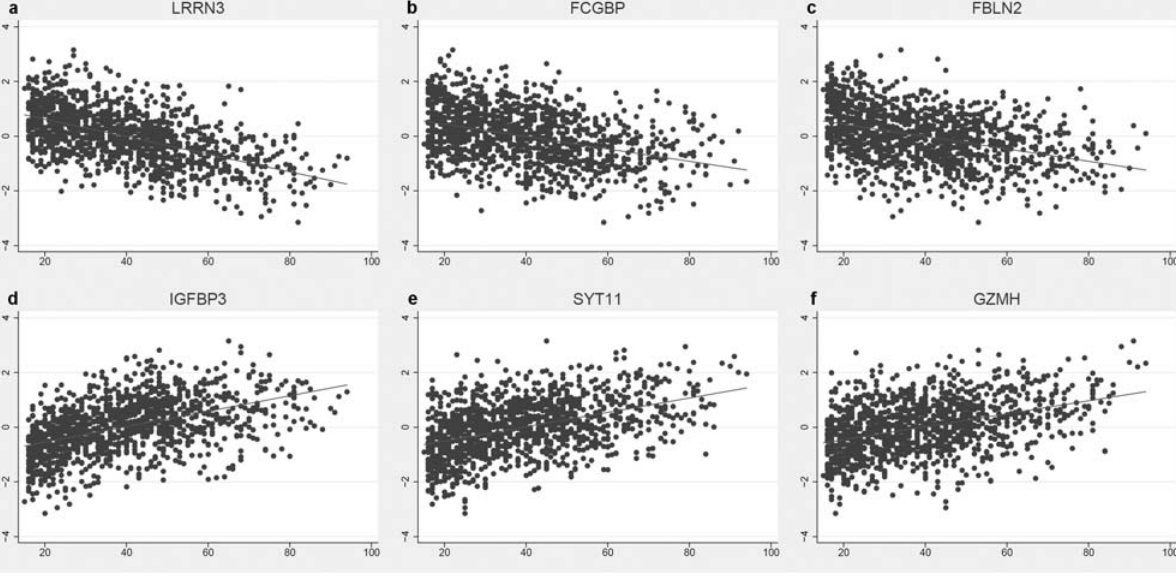
Figure 2. Scatter plots and fitted linear regression lines of the most significantly associated down-regulated (a–c) and up-regulated (d–f) genes with age in lymphocyte